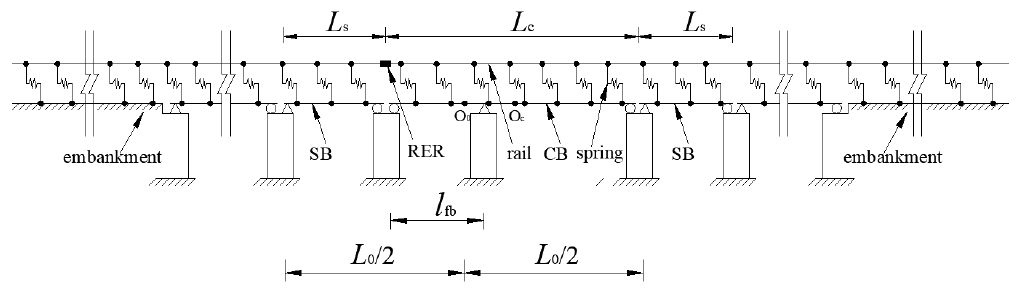
Figure 2. Schematic planar model of a continuously welded rail (CWR) track with the rail expansion regulator (RER) resting on bridges and embankments.